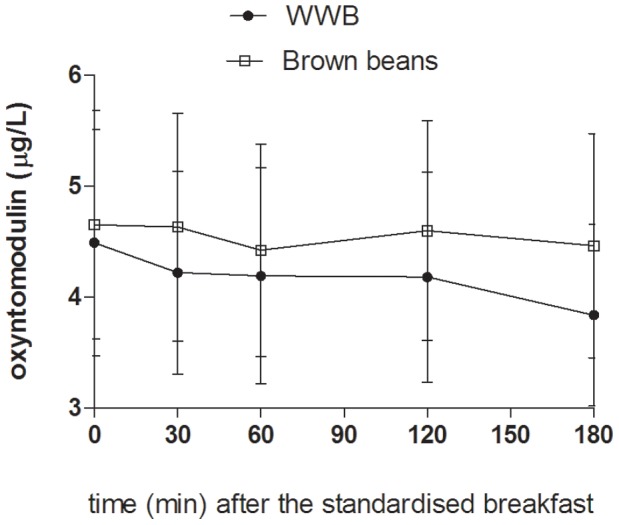
Concentrations of plasma oxyntomodulin fasting and after a standardized breakfast, consumed 11 hours after evening meals composed of brown beans or WWB.A significant treatment effect (type of evening meal) was found over the test period (p<0.05, PROC MIXED in SAS release 9.2; SAS Institute Inc, Cary, NC). n = 16 subjects.